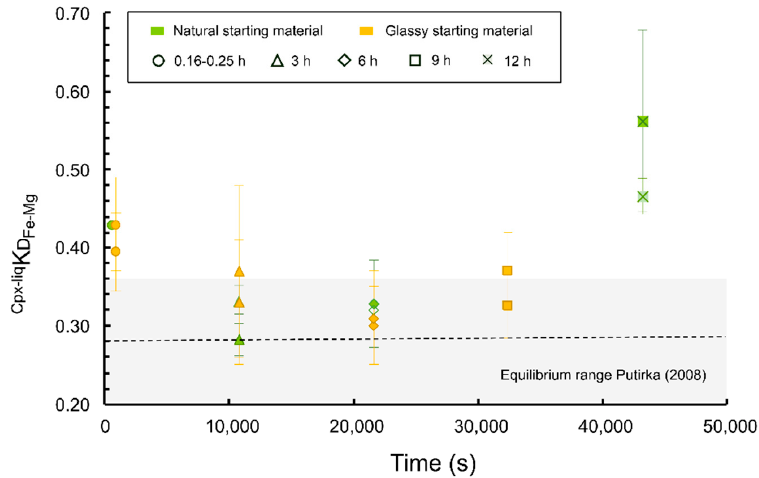
Figure 2. Relation between K D (Fe-Mg)Cpx-liq and time (s). The duration of each run is indicated with different symbols: circle for 0.16 and 0.25 h runs, triangle for 3 h runs, diamond for 6 h runs, square for 9 h runs and square with internal cross for 12 h run. Series are indicated with different colors: green for natural starting material, and yellow for glassy starting material. For natural starting material runs are used empty symbols for Cpx rims and full symbols for Cpx cores. The grey field represents the equilibrium range according to Putirka [57], while the dotted line represents the average K D value for Cpx (0.28 ± 0.08; [57]).